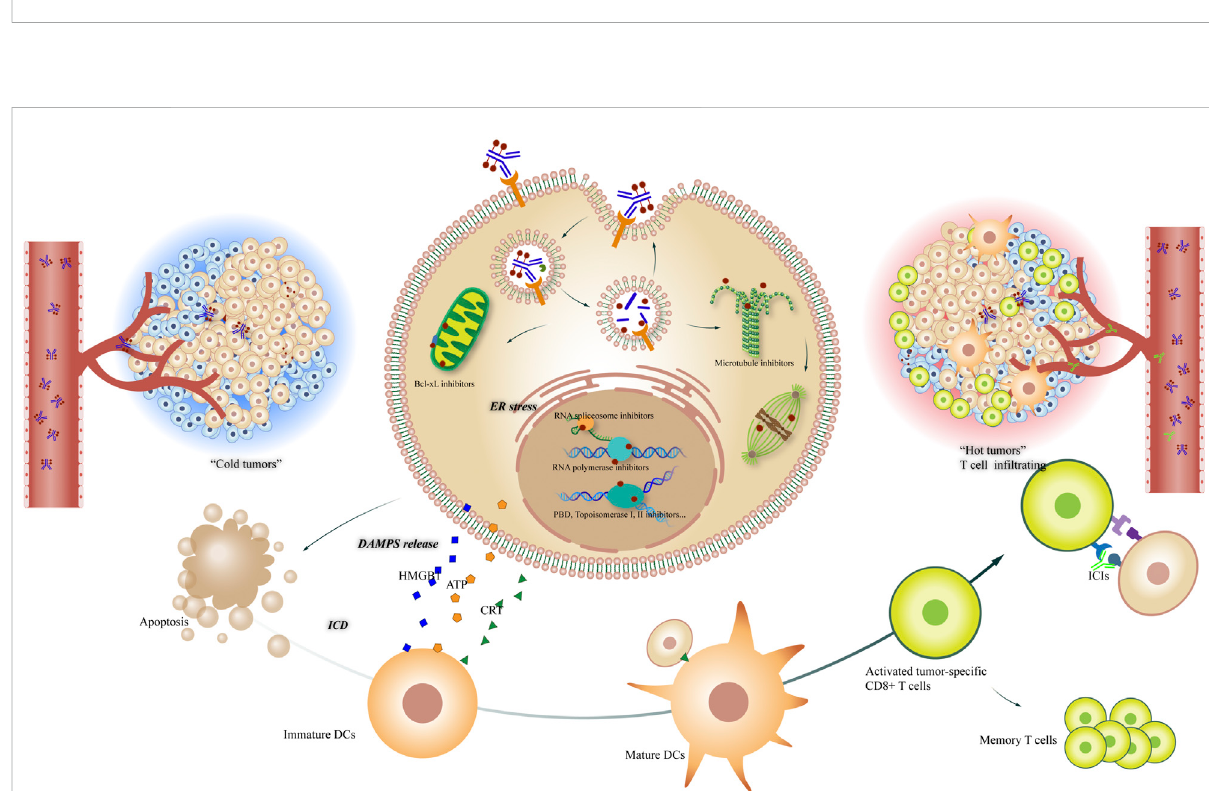
FIGURE 2 Dozens of ADCs are in clinical trials, most of them are in phase I or II and some of them have failed in this phase.